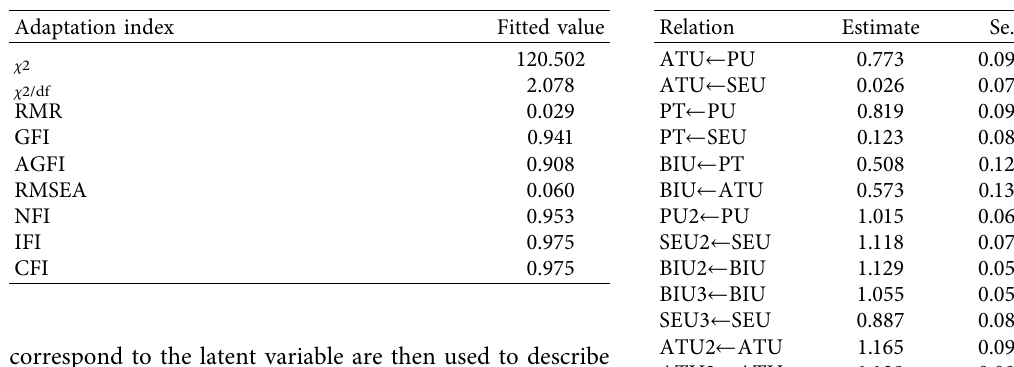
Figure 9: Structural equation model. Table 6: Model standardized path relationship values. Table 5: Index values of fitness for structural equation